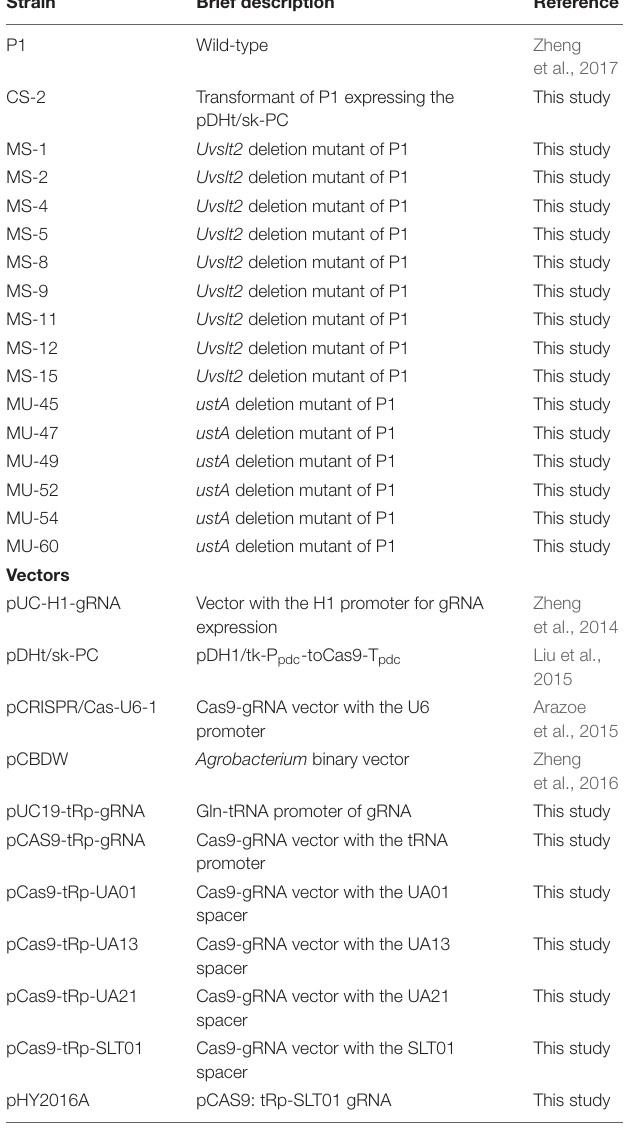
TABLE 1 | Strains and vectors used in this